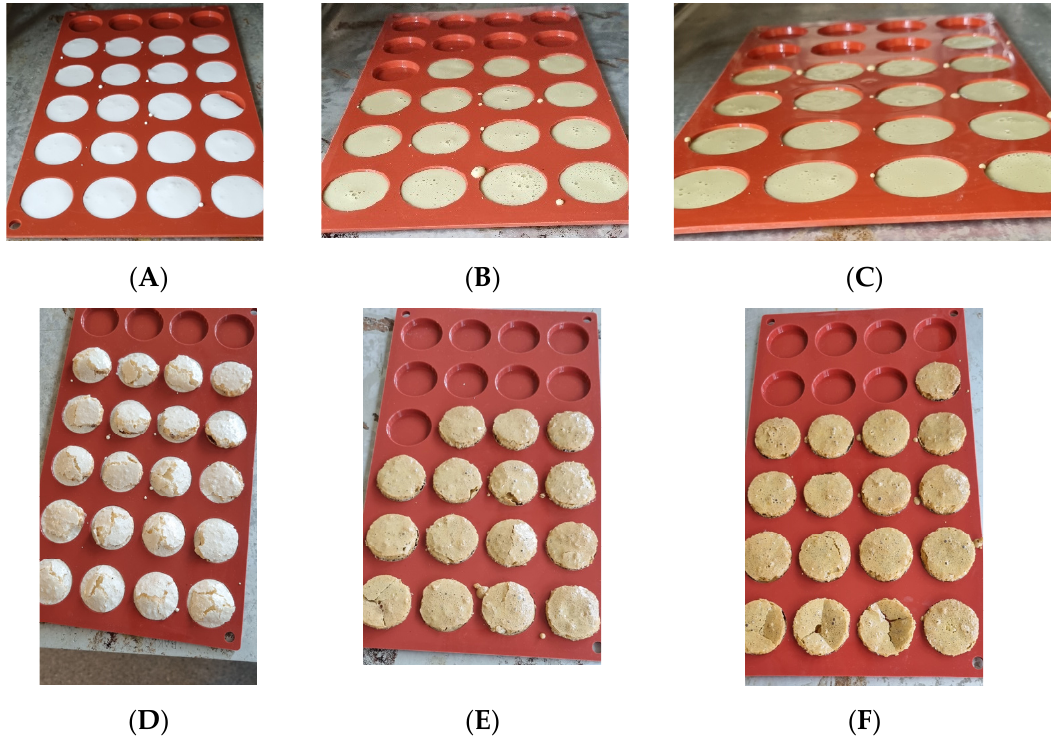
Figure 5. Pictures of the meringues before ( A – C ) and after cooking ( D – F ). Egg white ( A , D ), WT ( B , E ), WTS ( C , F ).